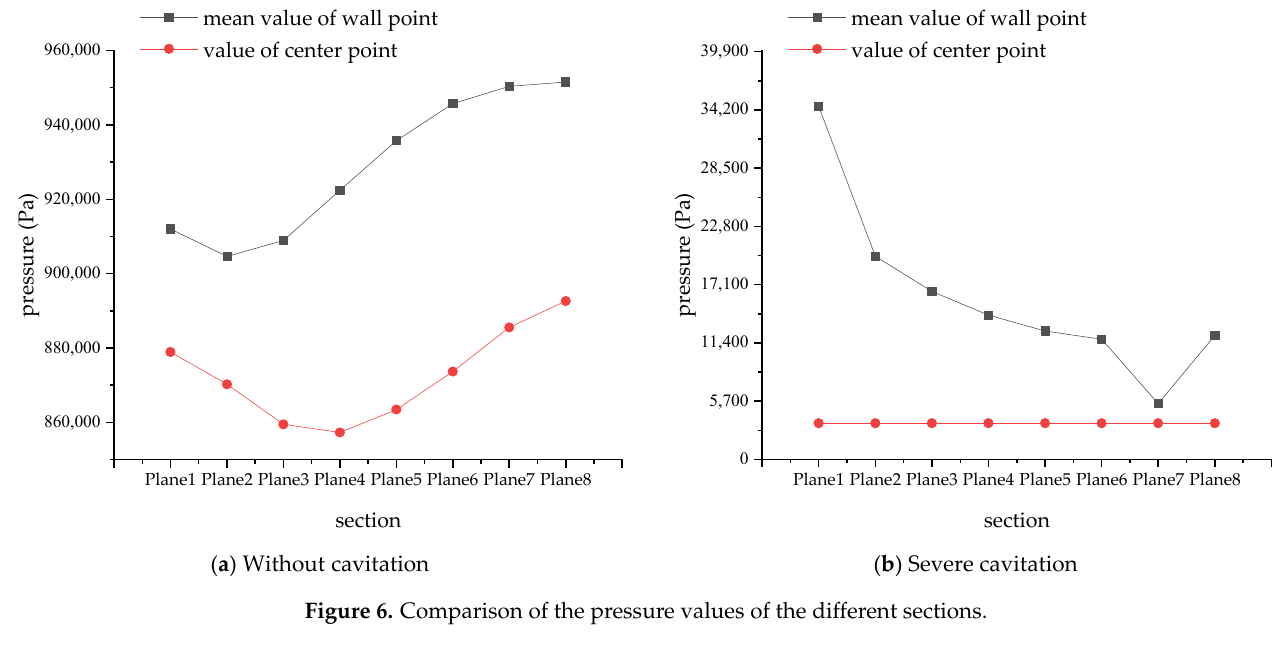
Figure 6. Comparison of the pressure values of the different sections.